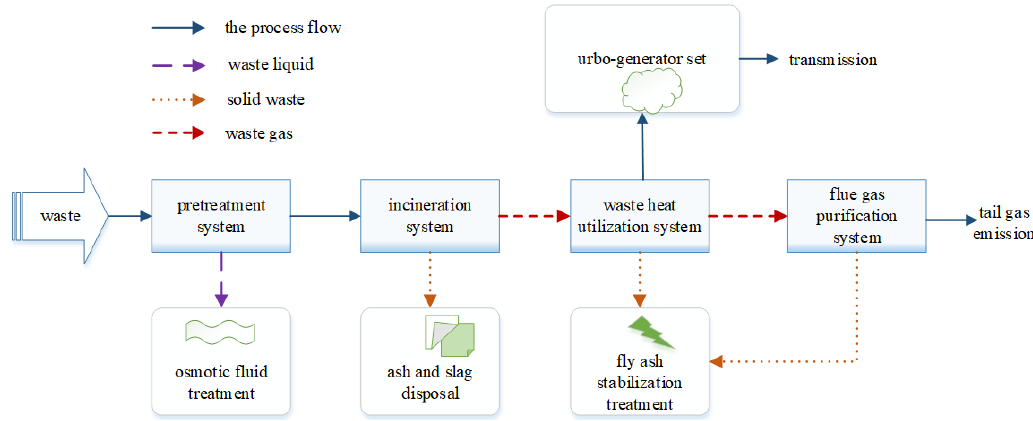
Figure 1. MSW incineration process flow.